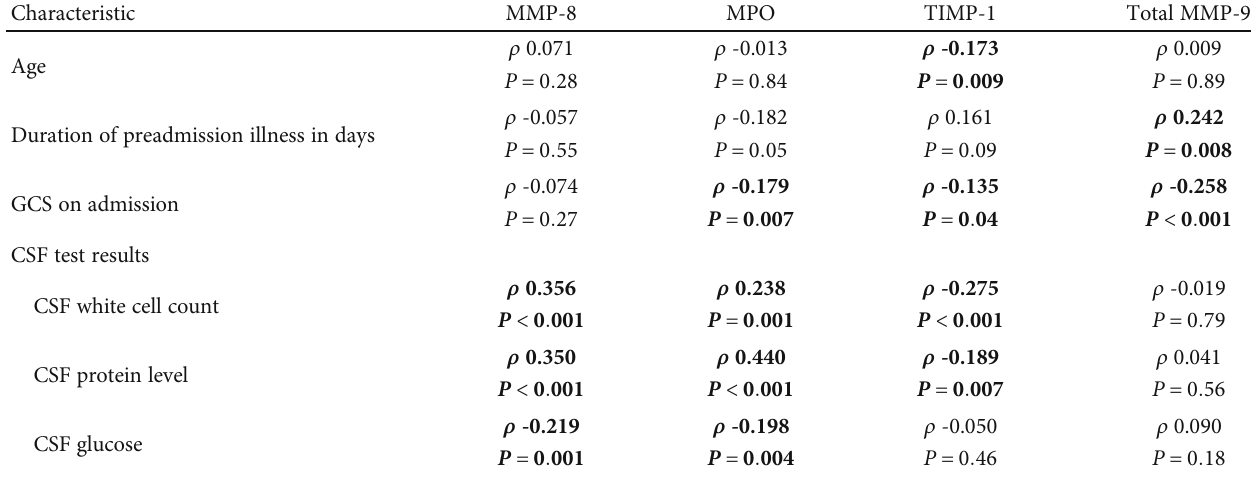
Table 2: Associations between MMP-8, MPO, TIMP-1, and MMP-9 and baseline patient characteristics a .